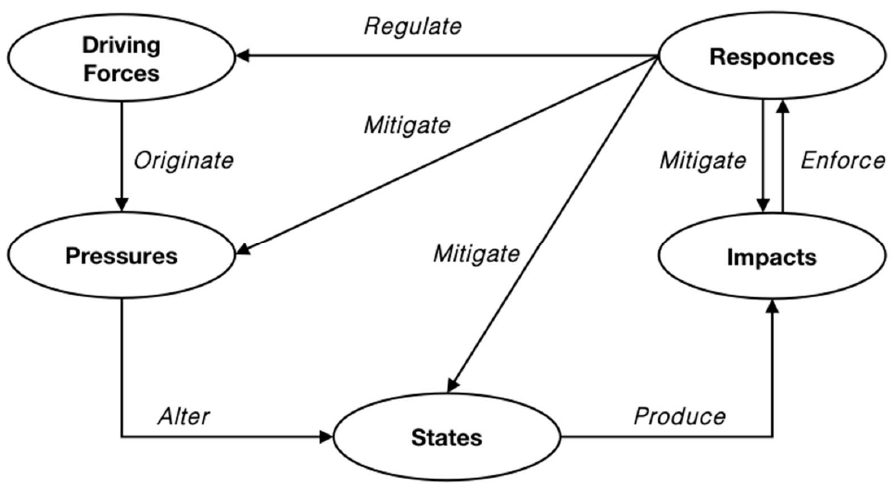
Figure 1. The general framework of DPSIR.